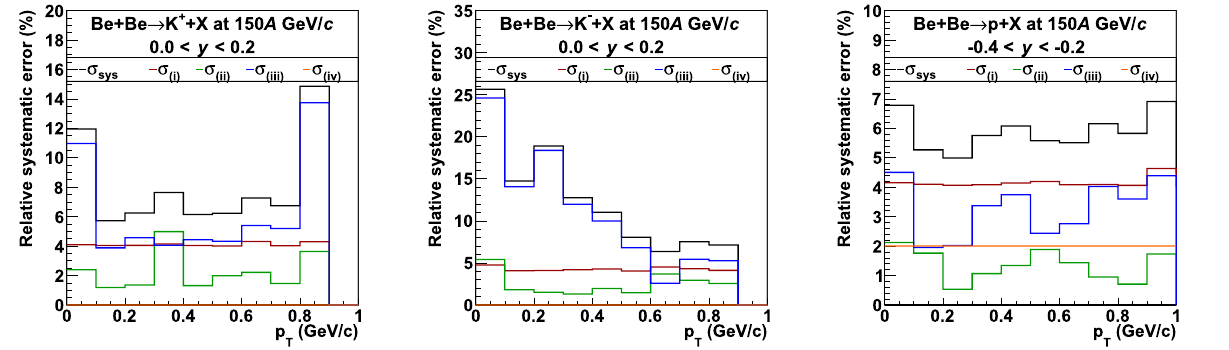
Fig. 19 Contributions to the systematic uncertainty of particle spectra obtained from the tof -d E / d x method at 150 A GeV / c as a function of p T for the rapidity interval 0.0 to 0.2 GeV / c ( K + and K − ) and − 0.4 to − 0.2 GeV / c (protons). σ (i) (red lines) refers to event selection σ (ii) (green lines) to the track selection procedure, σ (iii) (blue lines) to the